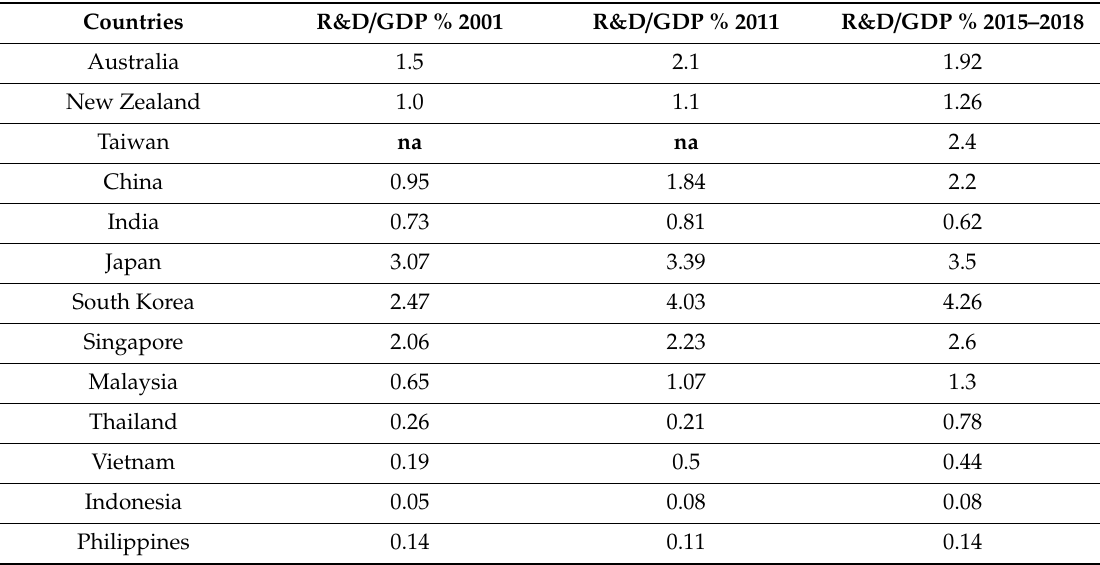
Table 3. Gross expenditure on R&D as a percentage of